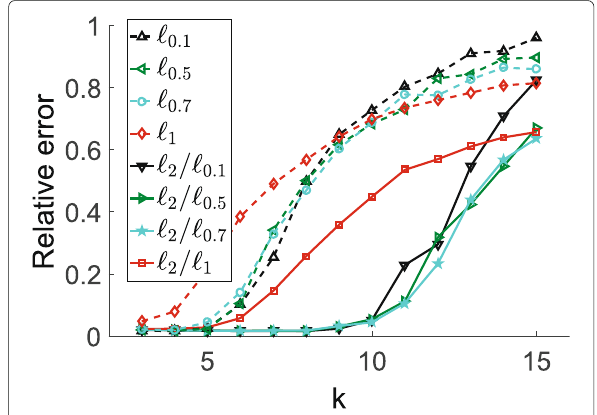
Fig. 2 Comparison of recovery performance among non-convex